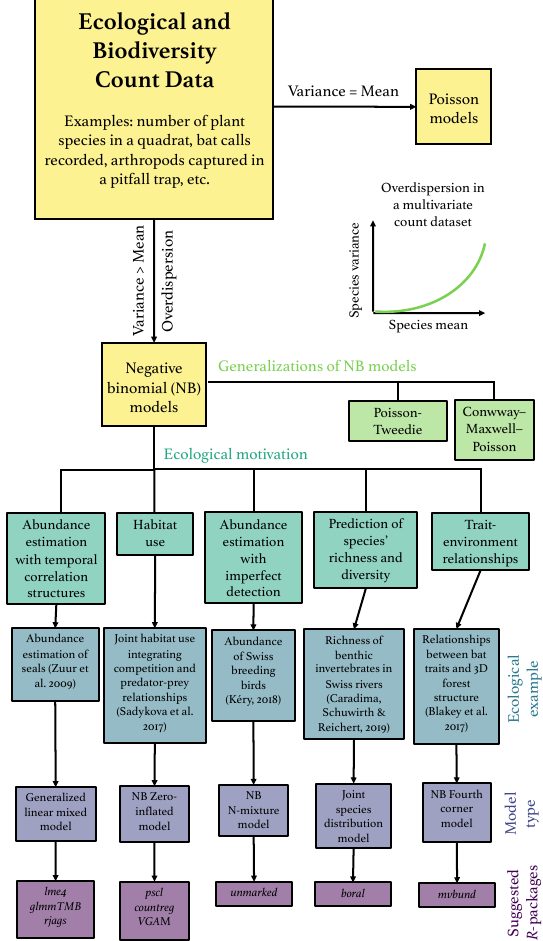
Figure 1. Flowchart of selected examples for existing, modern, and extensions of negative binomial (NB) models for count data to address a variety of ecological